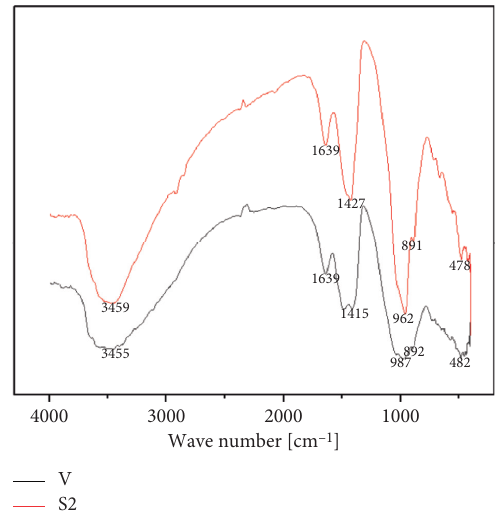
Figure 7: IR spectra of slag solidified body without adding SiC whisker (V) and with 1% SiC whisker